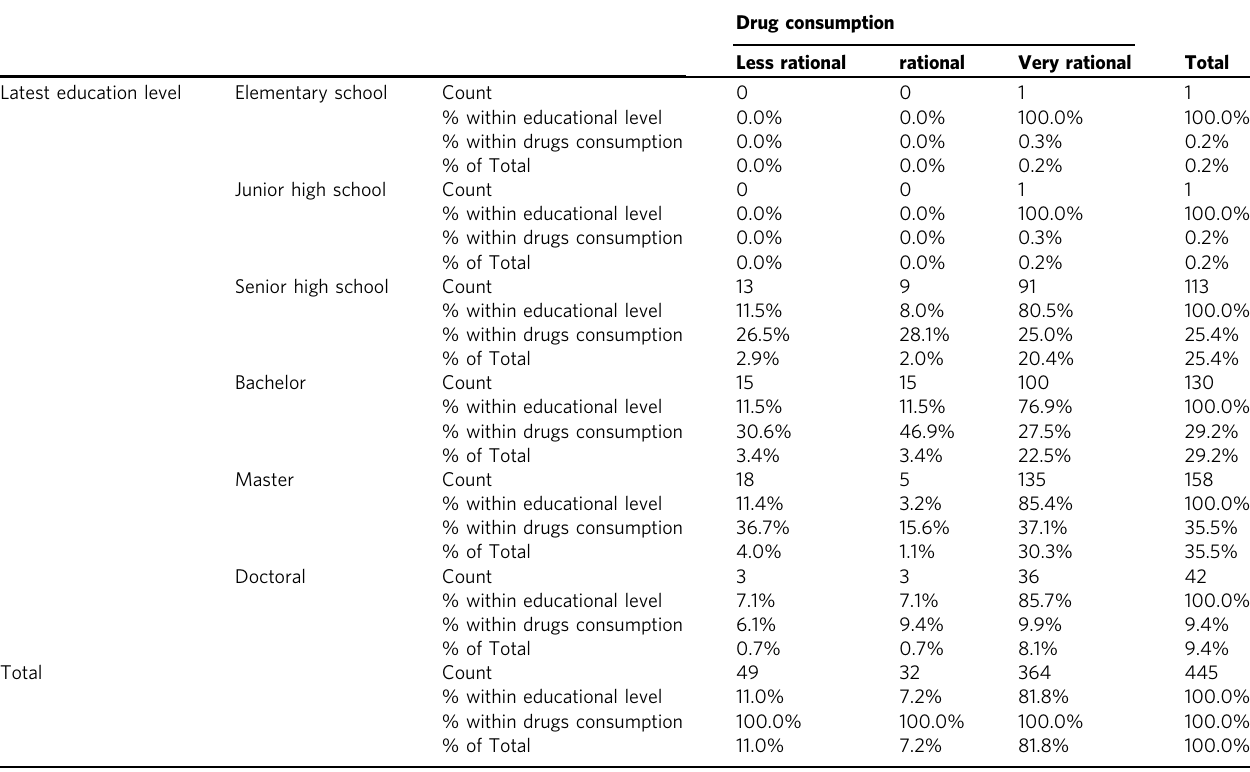
Table 1 Relations of educational level with drug consumption during Covid-19 using